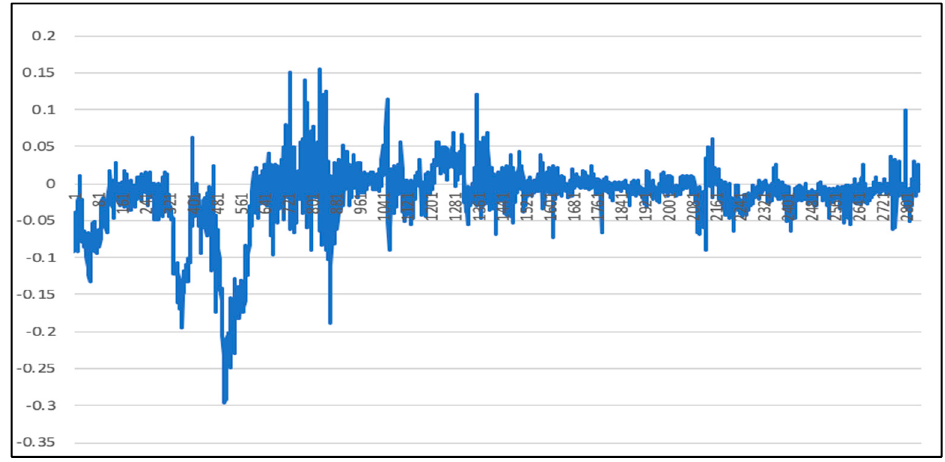
Figure 20. Error map of RF prediction results and actual results (first 2850 data).